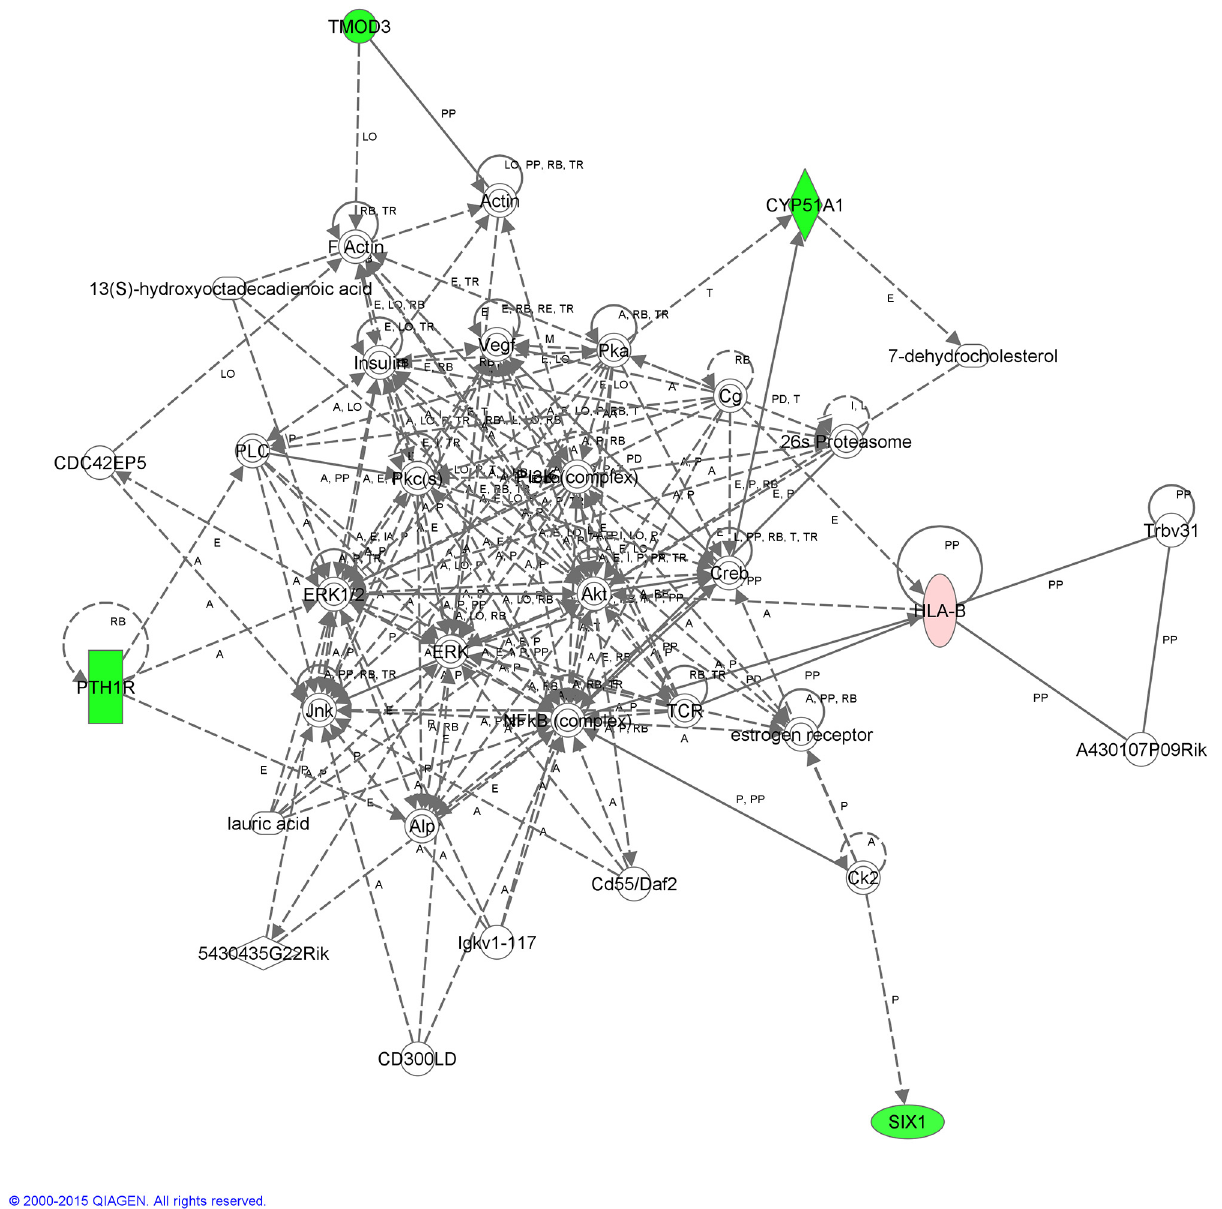
Fig 5. Interactome of functional associations among genes included in Network 3 by Ingenuity Pathway